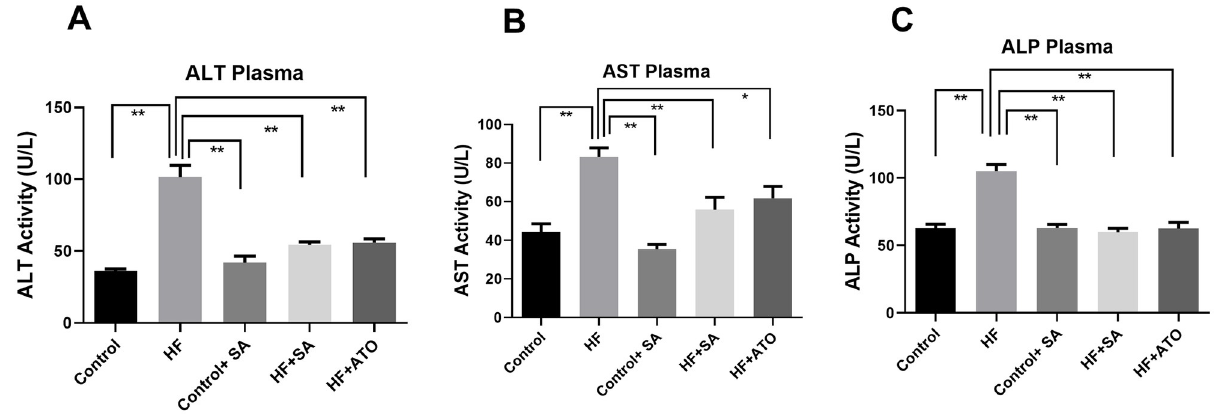
Fig 3. Effect of Senna alexandrina leaf powder supplementation on hepatic marker enzymes. A. ALT Plasma. B. AST Plasma. C. ALP in plasma. Mean ± standard error of mean (SEM) was used to express all values, where n = 8. Statistical analysis was done by one-way ANOVA and comparisons among the groups were done following Tukey’s multiple comparisons test. � represents p � 0.05; �� represents p � 0.001.